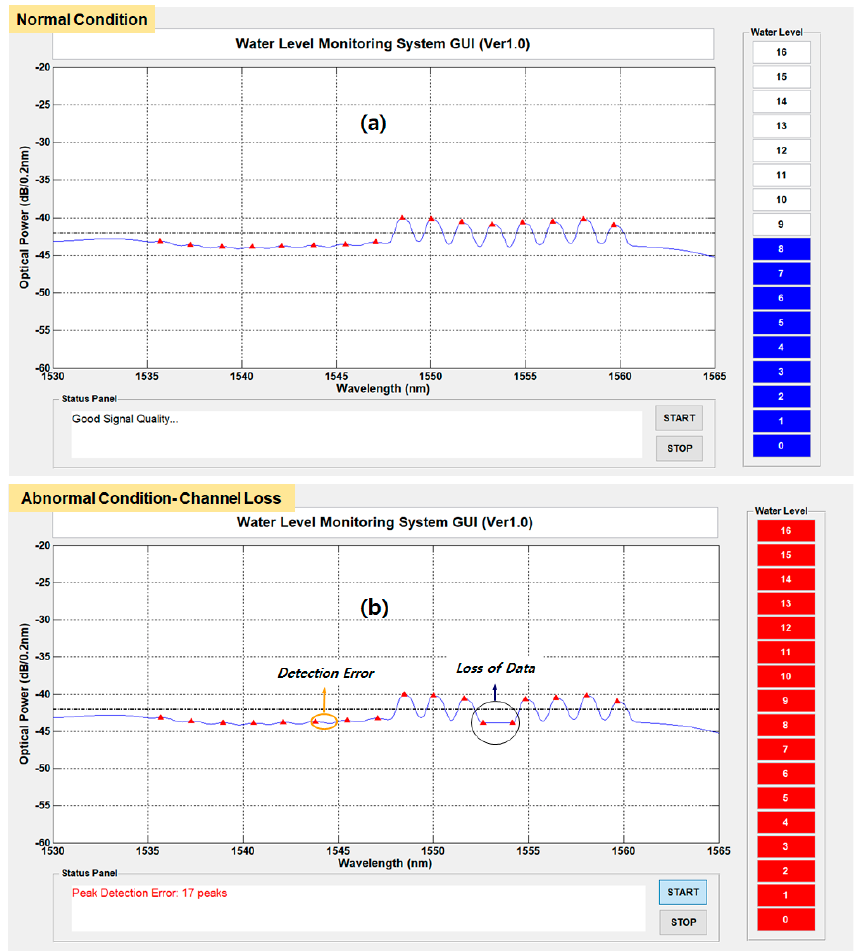
Figure 10. Measurement results with HMI display module at 25 km distances ( a ) normal condition, ( b ) abnormal condition. ( b ) abnormal